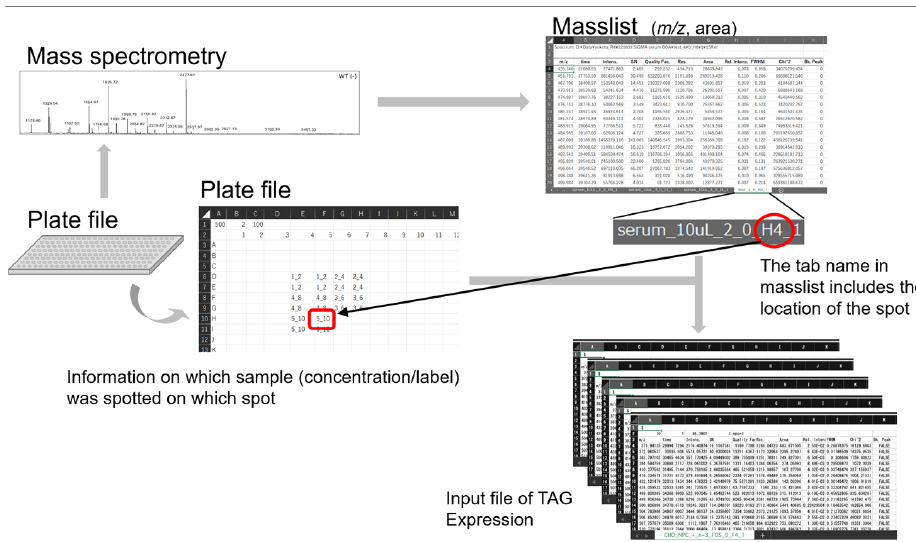
Figure 7. Automatic generation of input files of TAG Expression using plate file.